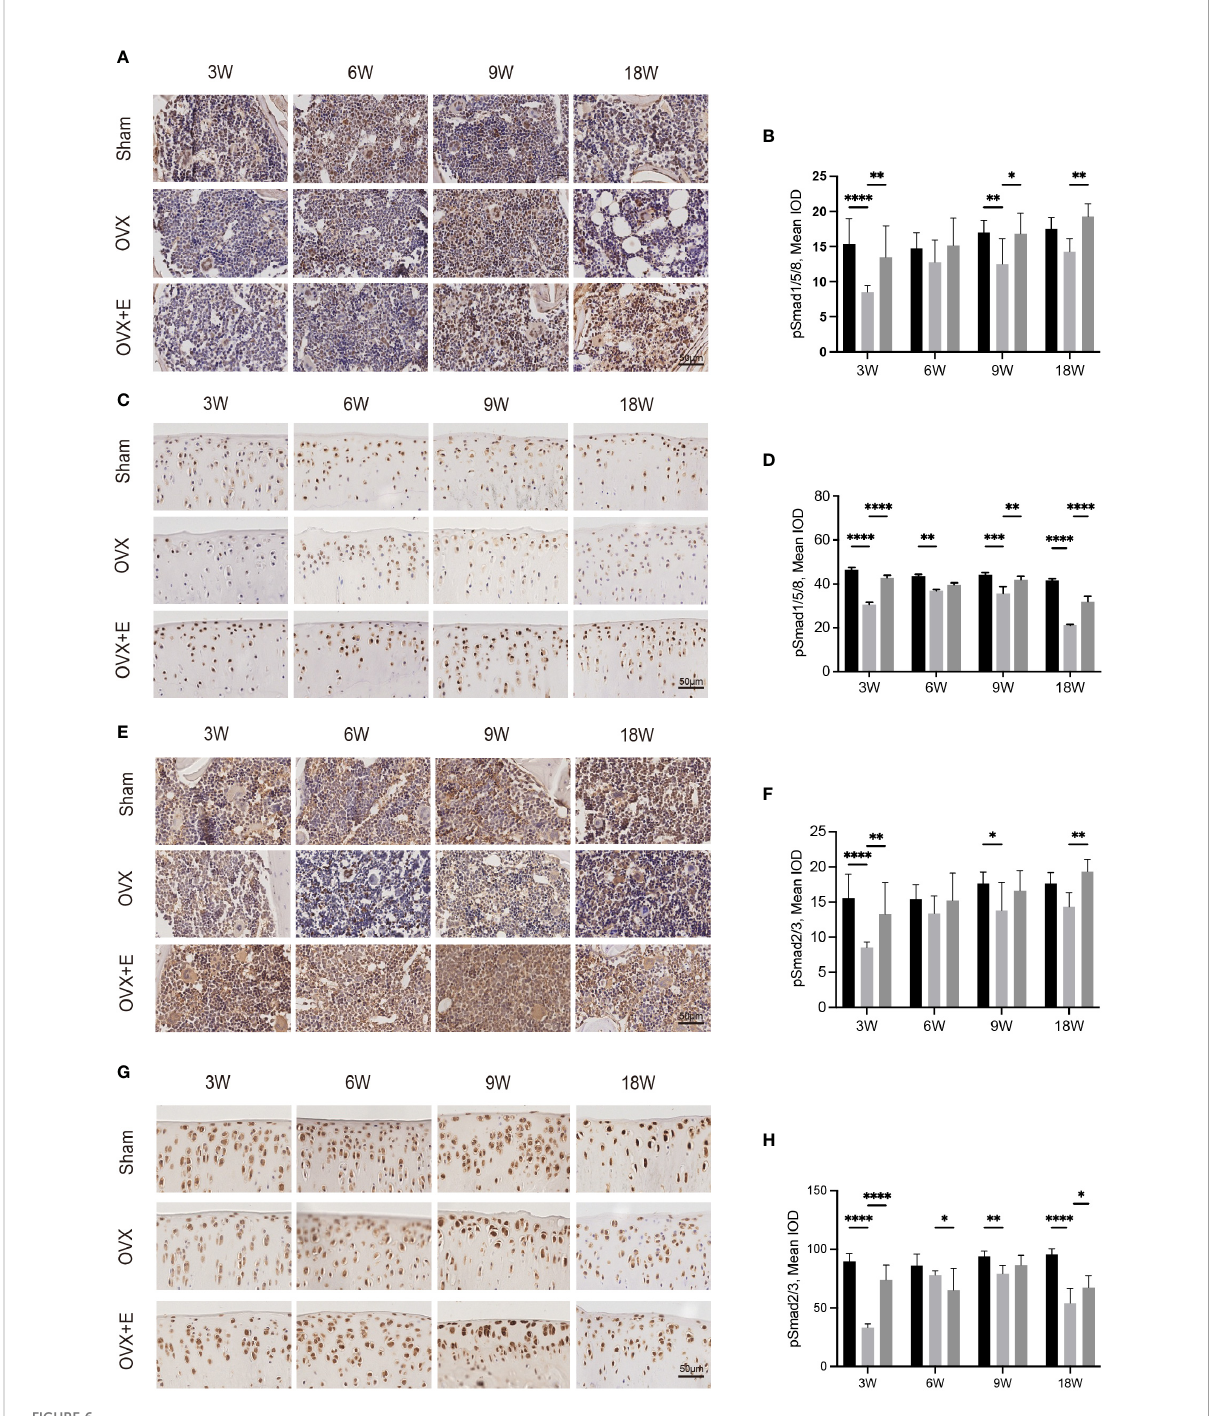
FIGURE 6 Immunohistochemical staining of pSmad1/5/8 in subchondral bone (A) and articular cartilage (C) . Immunohistochemical staining of pSmad2/3 in subchondral bone (E) and articular cartilage (G) . The mean IOD of pSmad1/5/8 in subchondral bone (B) and articular cartilage (D) . The mean IOD of pSmad2/3 in subchondral bone (F) and articular cartilage (H) (n = 7). The mean IOD indicates the mean integrated optical density. Scale bar, 50 m m. *p< 0.05, **p< 0.01, ***p< 0.001, ****p<